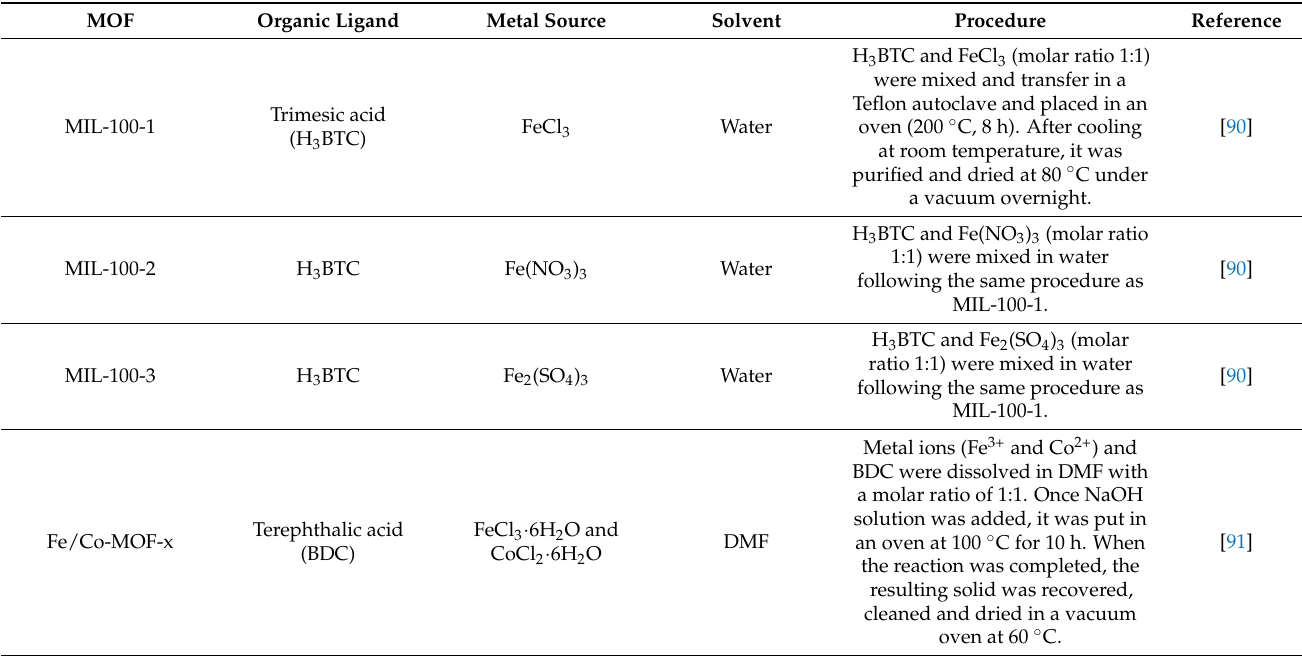
Table 4. Examples of solvothermal/hydrothermal synthesis of Fe-MOF.